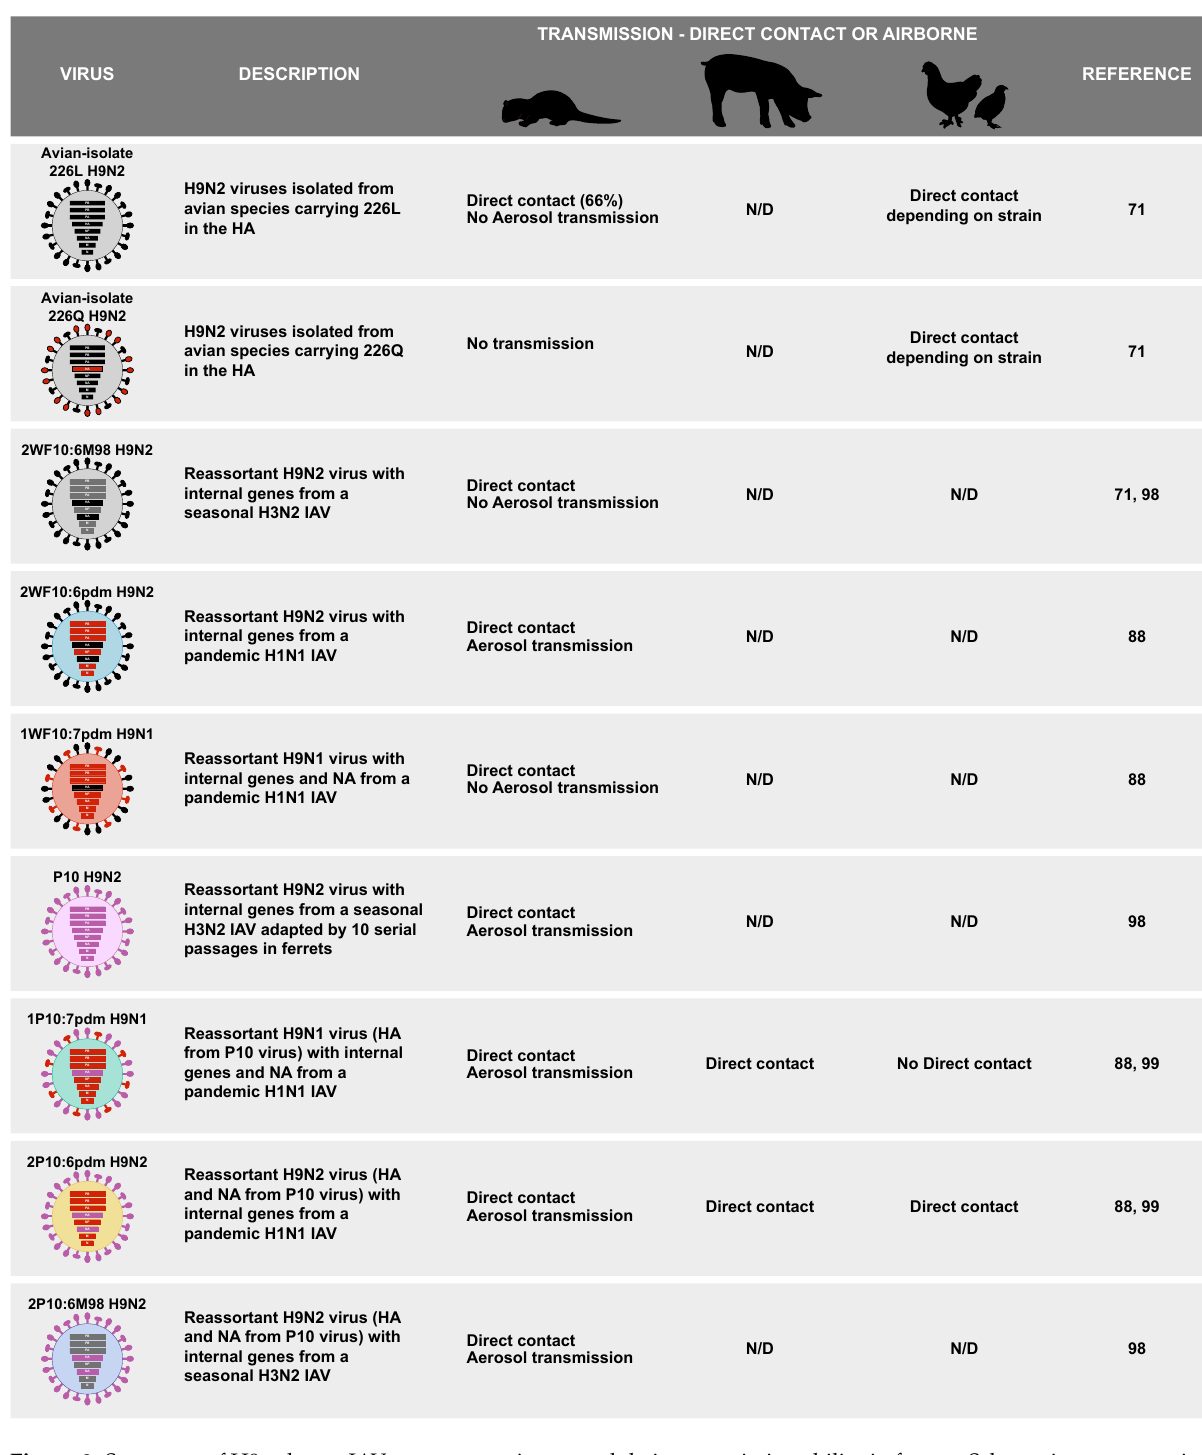
Figure 3. Summary of H9 subtype IAV reassortant viruses and their transmission ability in ferrets. Schematic representation of the different H9 subtype IAVs tested for transmission in ferrets by our group and described in this review, description of each virus, and type of transmission observed. Results compiled from [71,88,98,99].